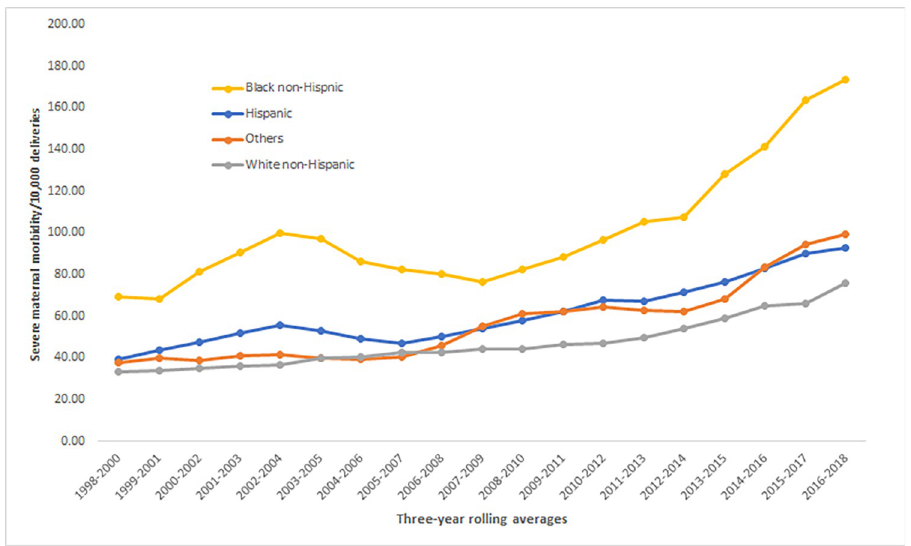
Fig 2. Severe maternal morbidity a by race/ethnicity using three-year rolling average: Massachusetts, 1998–2018. a Severe maternal mortality without blood transfusion (SMM20). https://doi.org/10.1371/journal.pone.0279161.g002 3.30 to 102.4. For transfusion, eclampsia, adult respiratory distress syndrome, ventilation, shock, conversion of cardiac rhythm, air and thrombotic embolism, cardiac arrest, and amni- otic fluid embolism, the Black/White rate ratios ranged from 2.00 to 2.97 (Table 1). Our stratified analyses using GEE for Black and White are shown in Table 2. Compared to birthing people aged 25–29 (reference group), there are no significant differences in SMM rates among birthing people aged less than 18 years among Whites [aRR 1.01 (95% CI: 0.75, 1.37)] and Blacks [aRR 0.91 (95% CI: 0.62, 1.32)]. However, among birthing people ages 18–